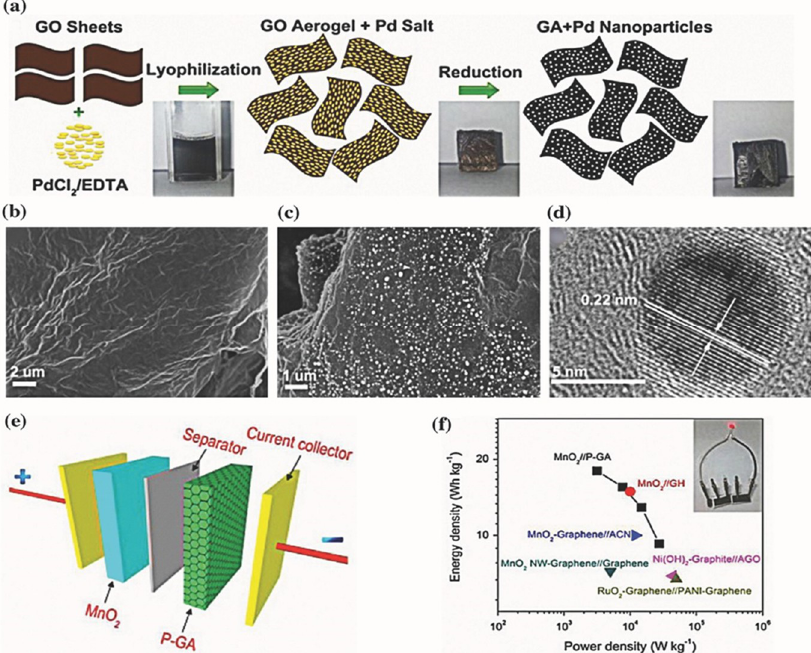
Figure 15. ( a ) Schematic illustration showing the fabrication process of P‐GA. ( b,c ) SEM images of the GA ( b ) and P-GA ( c ). ( d ) HRTEM images of P-GA. ( e ) Schematic showing ASC device construction using MnO 2 and P-GA electrodes. ( f ) Ragone plot reflecting the superiority of P-GA nanostructures over other electrode materials. The inset shows a red LED powered by using two devices connected in series. Reprinted from [167] with permission, copyright American Chemical Society, 2015.